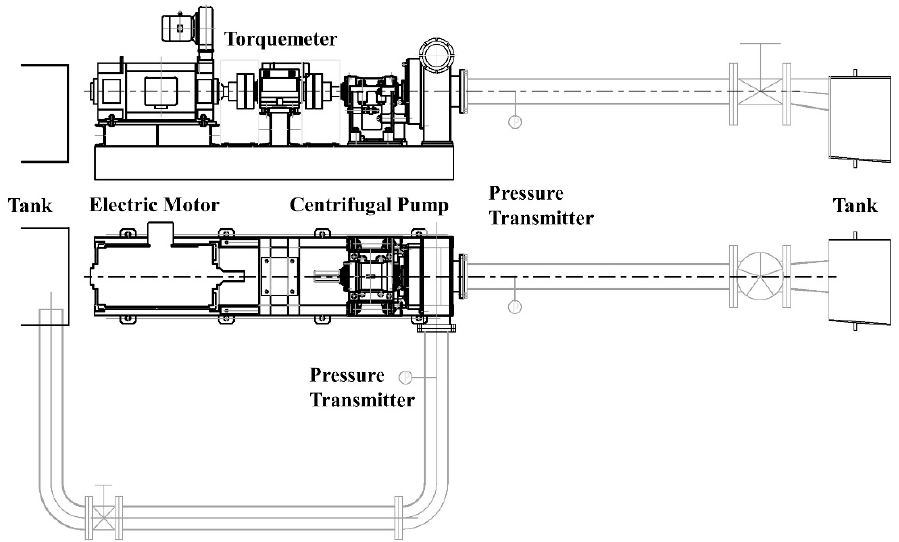
Figure 4. Experimental setup of the centrifugal pump.